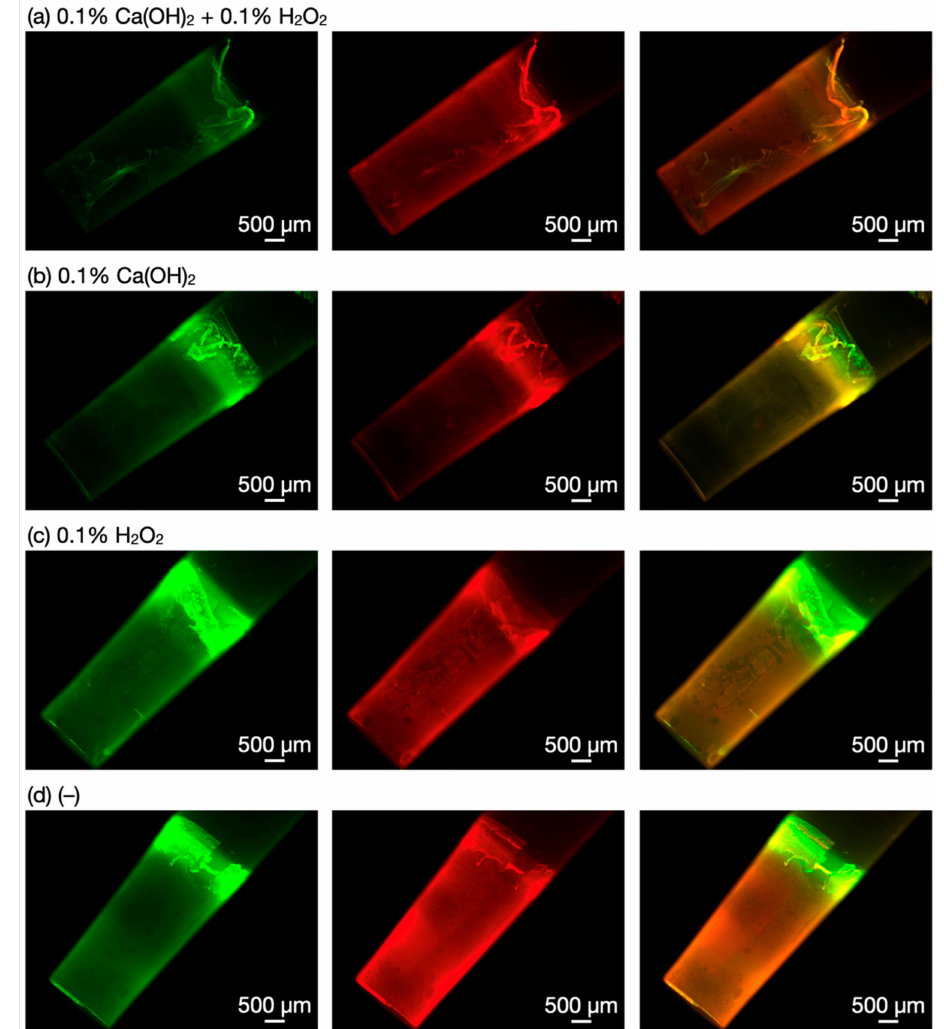
Figure 4. Fluorescence microscopy images of biofilms after the treatments with ( a ) 0.1% Ca(OH) 2 – 0.1% H 2 O 2 , ( b ) 0.1% Ca(OH) 2 , and ( c ) 0.1% H 2 O 2 and ( d ) nontreated biofilms. Each image visualizes a polypropylene pin with biofilms. The green fluorescence (left) and the red fluorescence (middle) correspond to SYTO 9 and propidium iodide, respectively. Merged images of the two channels are shown in the right